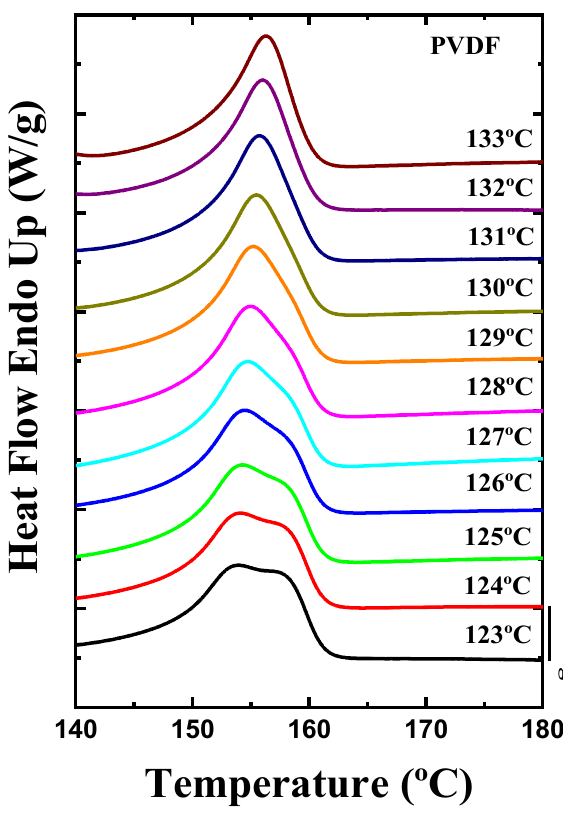
Figure 7. DSC heating scans after the isothermal crystallization process of PVDF homopolymer. The DSC heating scans for random copolymers at different compositions after the isothermal crystallization processes are presented in Figure 8. All the samples presented have the same behavior, where only one melting peak is observed and located at around 150 ◦ C. This melting peak corresponds to a crystalline structure composed essentially of TG + TG − chains (i.e., the α -phase) because the melting temperature observed occurs at higher temperatures than the Curie temperature for all the samples. All the isothermal crys- tallization curves for the PVDF homopolymer and the random copolymers are presented in Figure